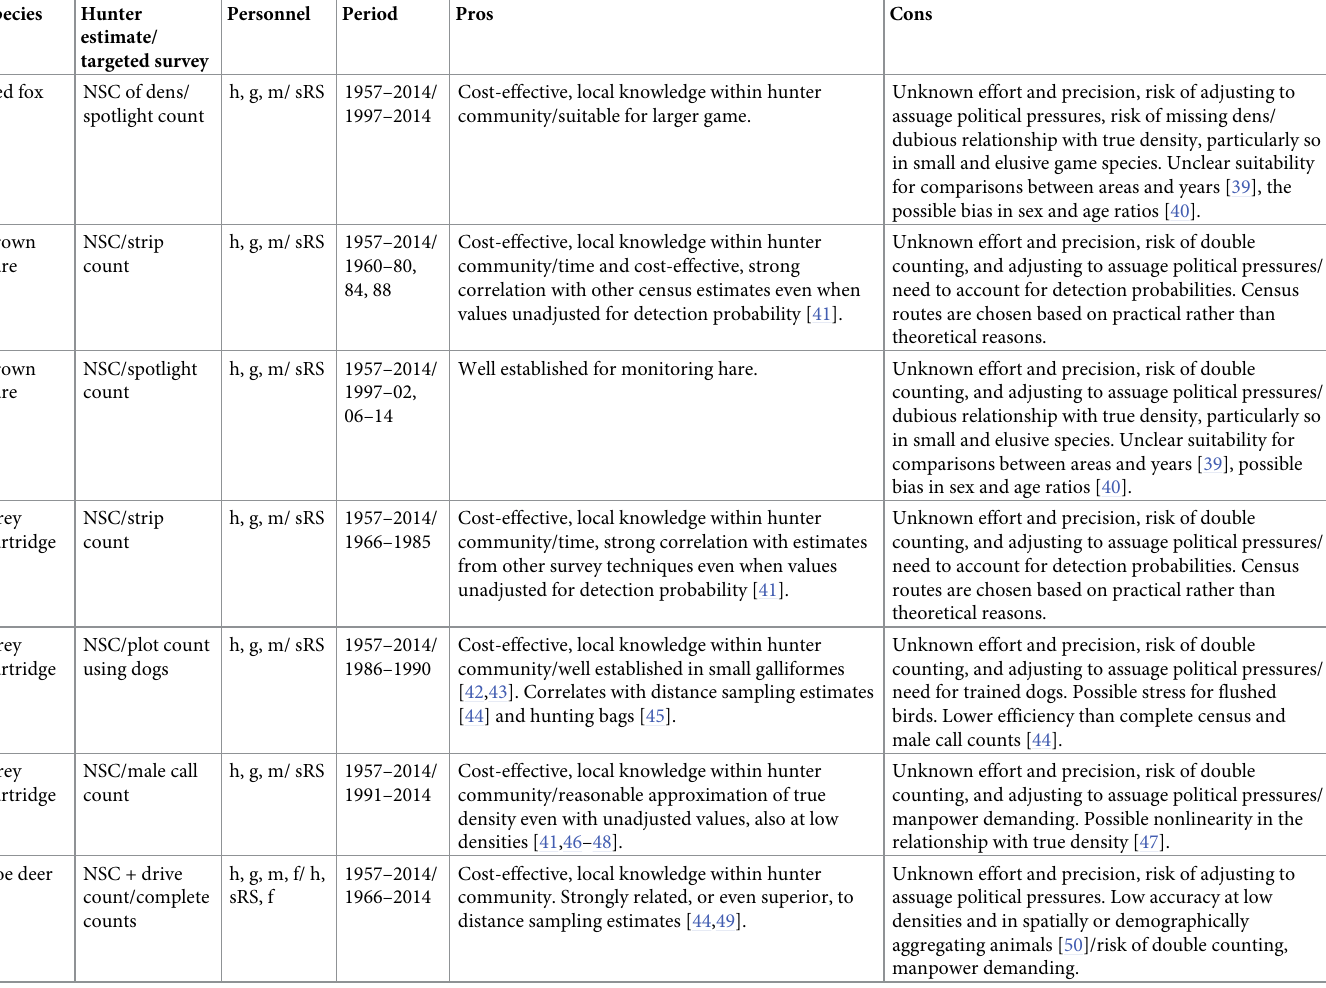
Table 1. Types and the period of surveys used to estimate relative game densities for red fox ( Vulpes vulpes ), brown hare ( Lepus europaeus ), grey partridge ( Perdix perdix ), and roe deer ( Capreolus capreolus ) at Czempi ń , Poland from 1960 to